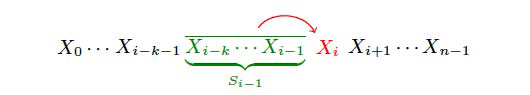
Markov model for sequence classification. Dependency of Xi on Xi−k,…,Xi−1 in a kth order Markov model.